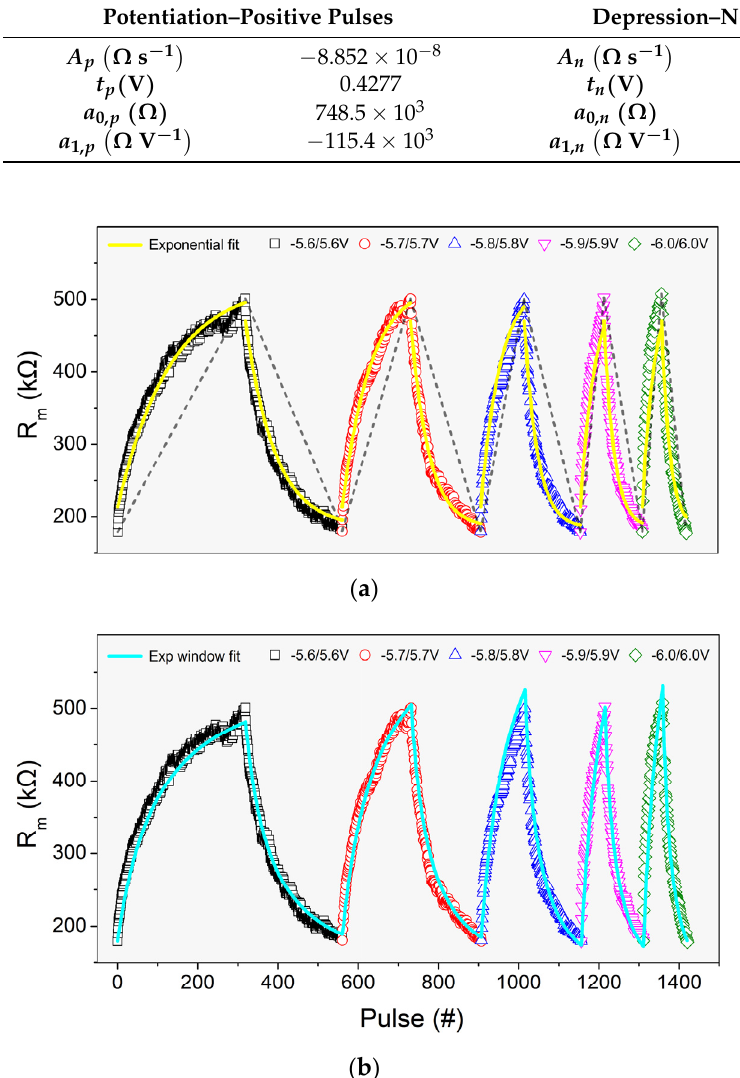
Figure 6. ( a ) Exponential (upper, yellow curve) and ( b ) windowed exponential (lower, cyan curve) fitting models.